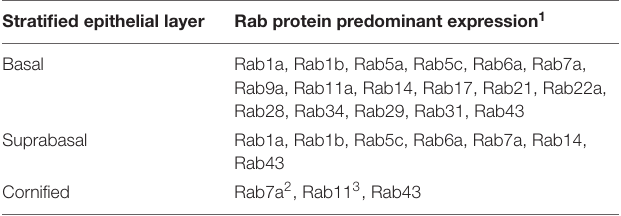
TABLE 2 | Rab expression in human skin and cervical